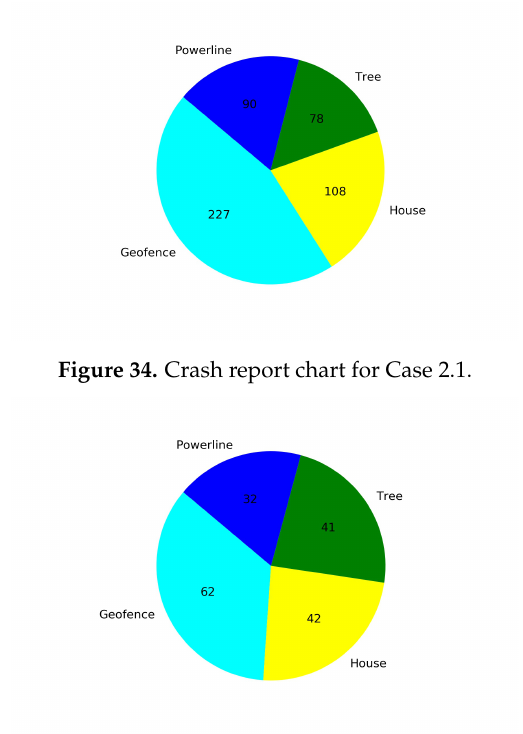
Figure 35. Crash report chart for Case 2.2 by Transfer Learning.